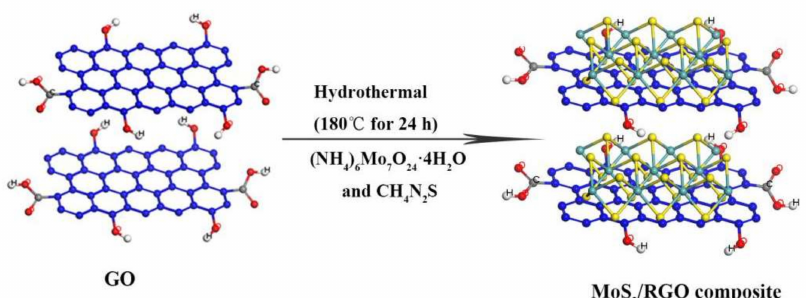
Figure 1. Schematic diagram of MoS 2 /RGO composite with reduced graphene oxide (RGO) as